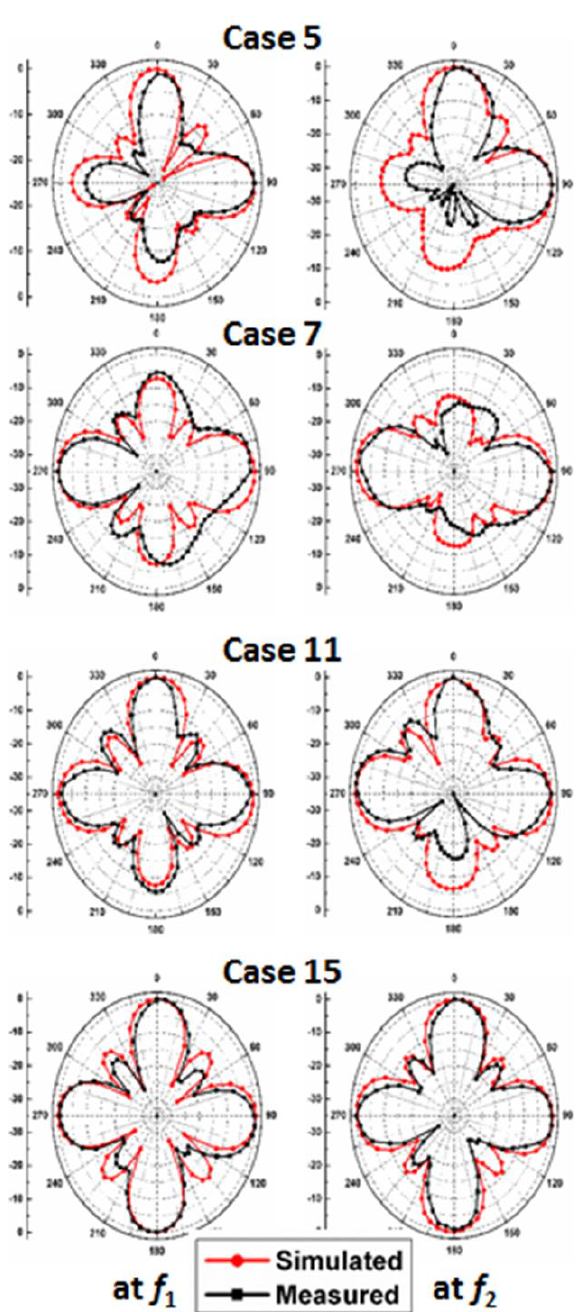
Figure 9: Measured and simulated radiation patterns in azimuth